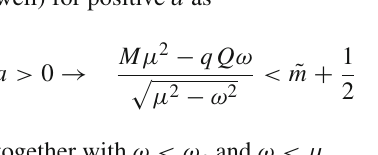
Fig. 9 Radial modes (cid:13) lm as function of r ∈ [ 12 , 100 ] without trapping well: (left) exponentially decaying function with V aKN ( r ) and (right) exponentially decaying function with V aaKN ( r ) . All parameters go together with Fig. 2